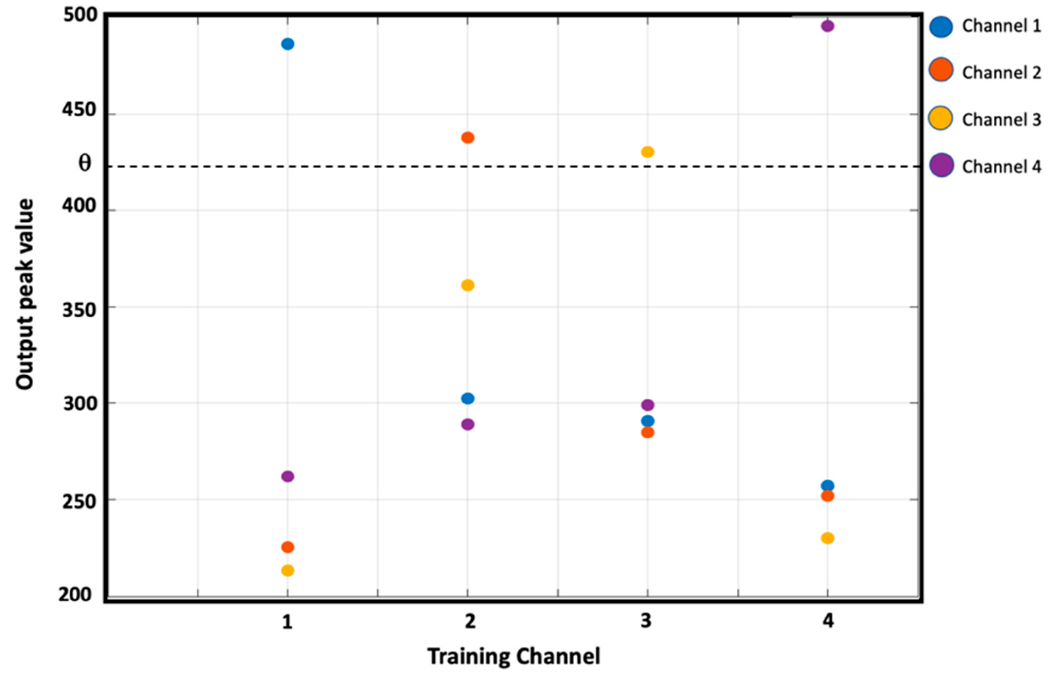
Figure 10. Amplitudes of the output signals for the different training numbers. As shown, for each training number, there is only one channel whose amplitude exceeds a threshold value identified by the dashed horizontal line.